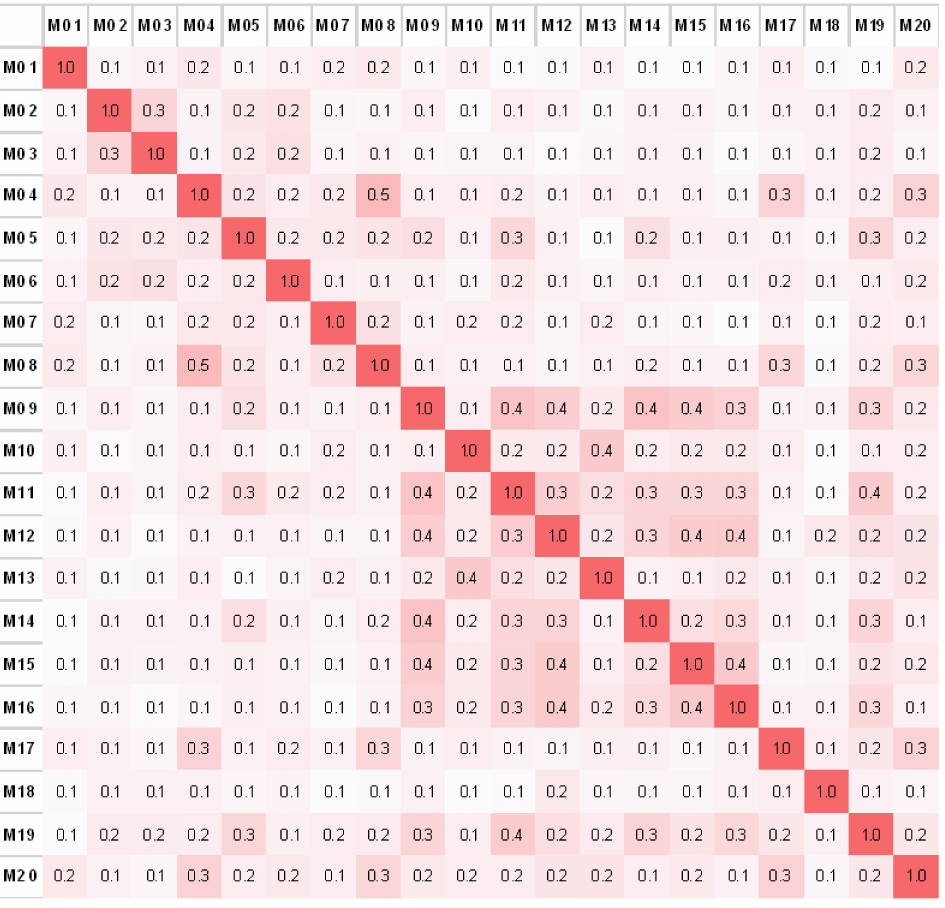
Figure 11. The correlation matrix with matching peak percentage plotted over a selection (M01–M20) of antibody fingerprints. The higher the color intensity, the higher the spectral overlap between two antibody fingerprints.